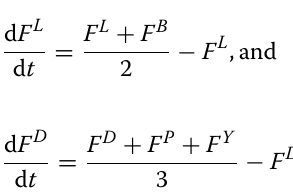
Table 13 Initial values for the factor scores of the ECDM ECDM factor Symbol Quintiles 1–3 Quintiles Child aptitude F B 0.58 0.66 ECD program quality F D 0.74 0.80 Family support F F 0.75 0.79 Practitioner quality F Y 0.58 0.68 Child health F H 0.85 0.85 ECD infrastructure quality F I 0.89 0.92 Later academic success F L 0.58 0.73 Family poverty F V 0.32 0.90 Child stunting F T 0.60